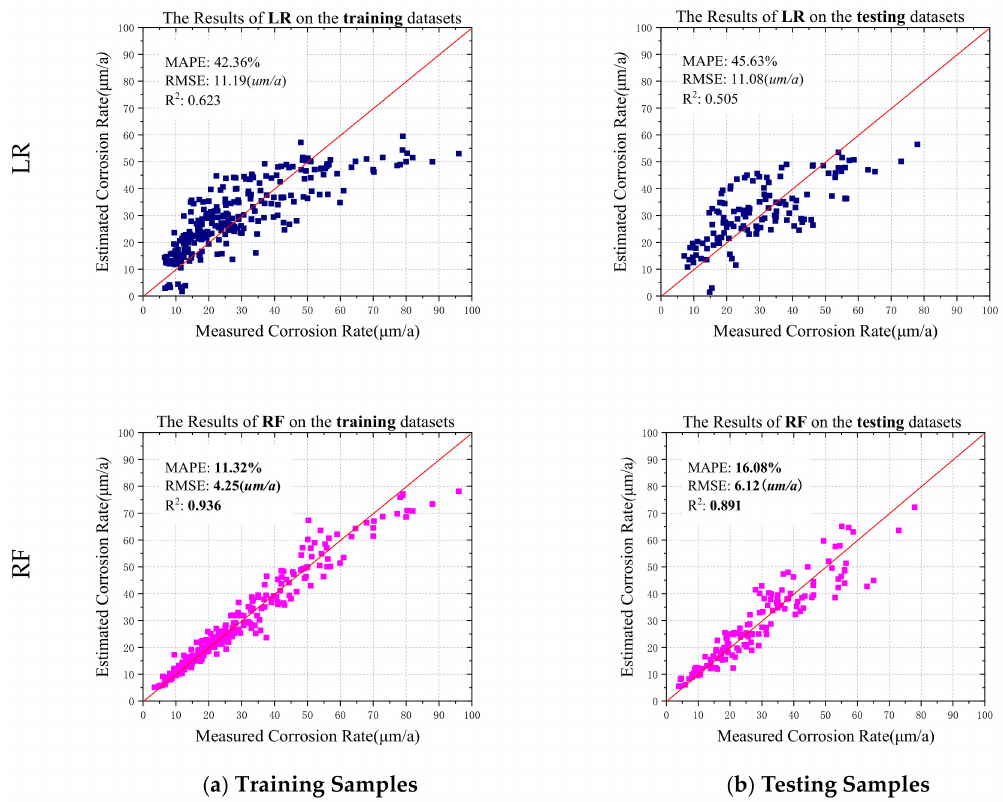
Figure 6. The prediction results of artificial neural network (ANN), support vector regression (SVR), logistic regression (LR), and RF on training ( a ) and testing ( b )